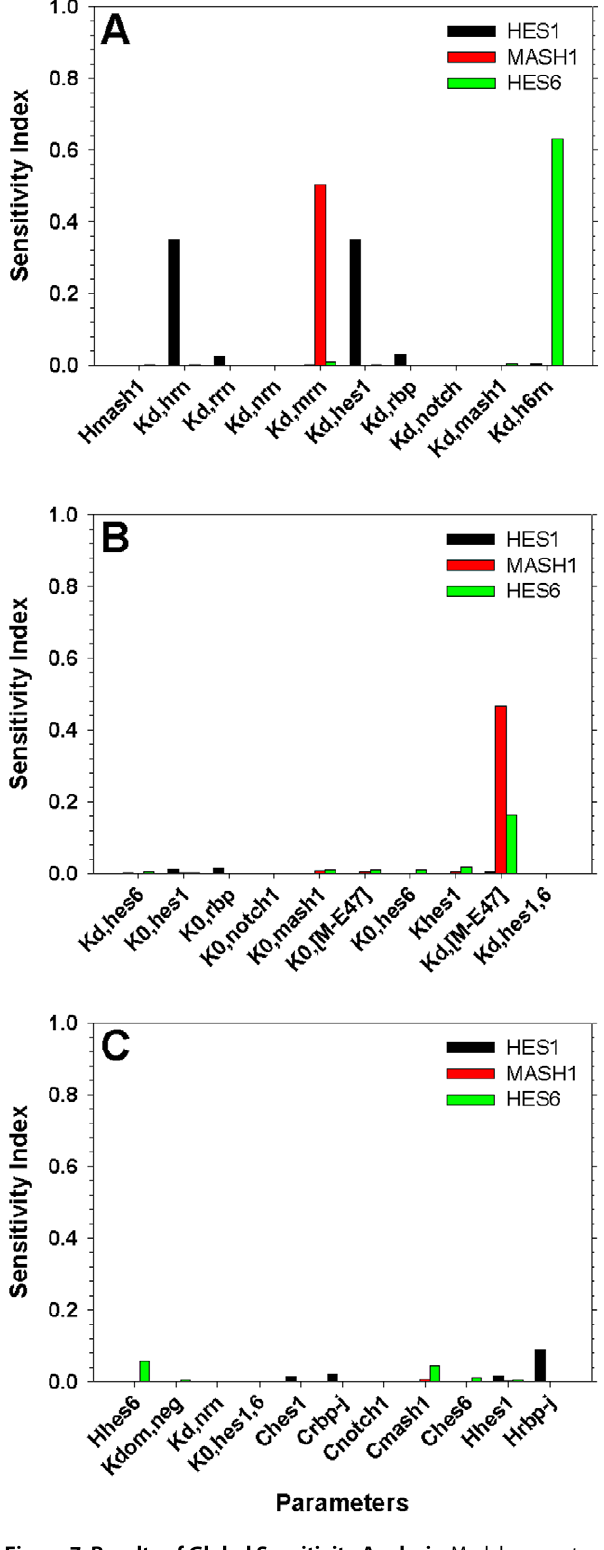
Figure 7. Results of Global Sensitivity Analysis. Model parameters were varied within 6 90% of their optimal value and their effect on the model output (black bars – Hes1, red bars – Mash1, green bars – Hes6) was analysed using the Derivative Based Global Sensitivity Measures.